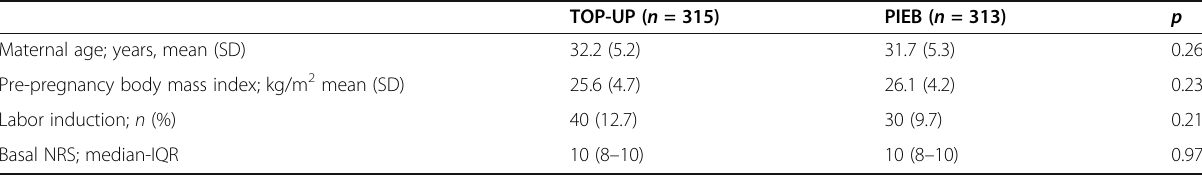
Table 1 Patients demographics and obstetric